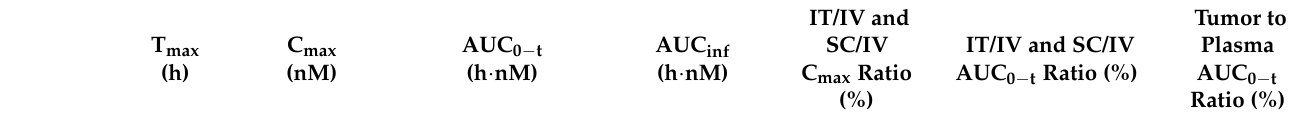
Table 2. Plasma and tumors PK parameters for ADC analytes observed after intravenous (IV), intra- tumoral (IT), and subcutaneous (SC) administration of 10 mg/kg of T-vc-MMAE ADC single